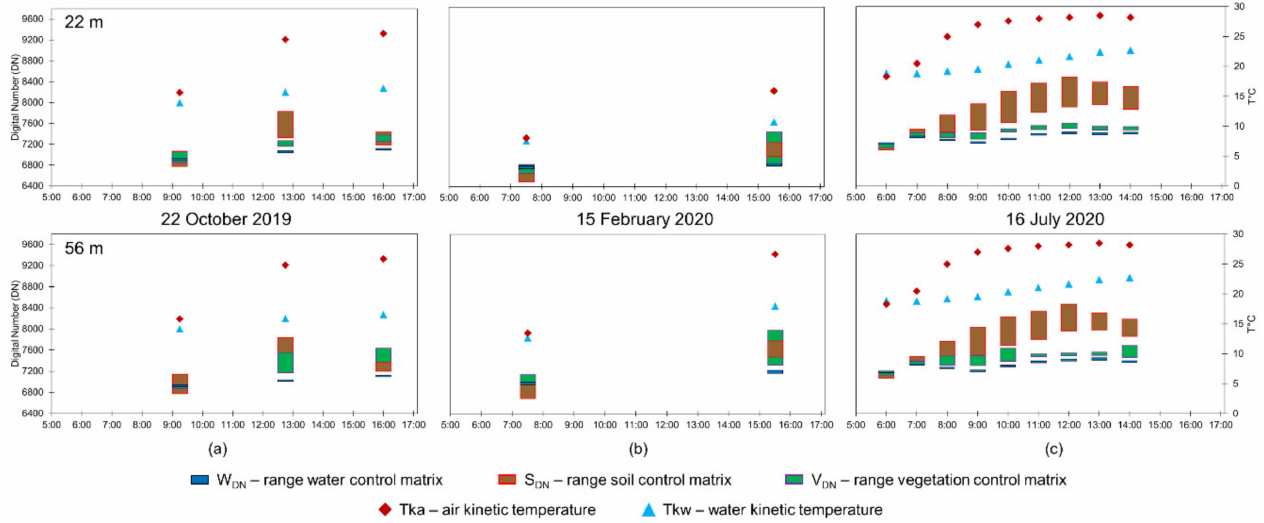
Figure 3. Time evolution of the DN ranges of the control matrices of water (W DN ), soil (S DN ), and vegetation (V DN ) and observed kinetic temperatures of water (Tkw) and air (Tka) in the three survey days: 22 October 2019 ( a ), 15 February 2020 ( b ) and 16 July 2020 ( c